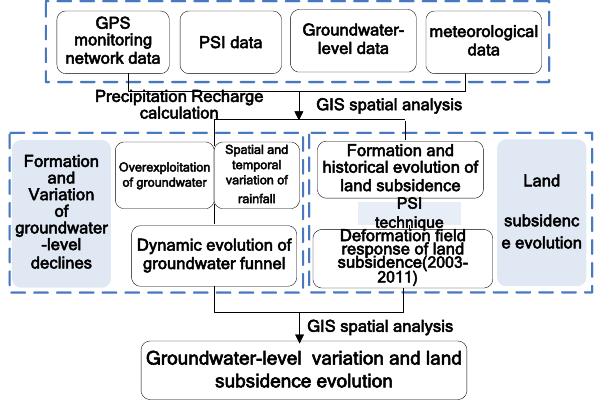
Figure 1. Framework diagram of the comprehensive analysis